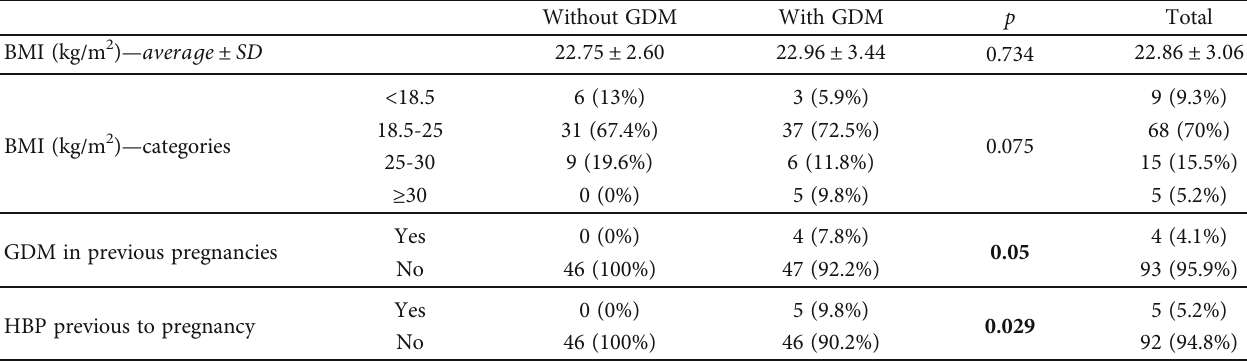
Table 3: Pathological personal history in the 2 studied